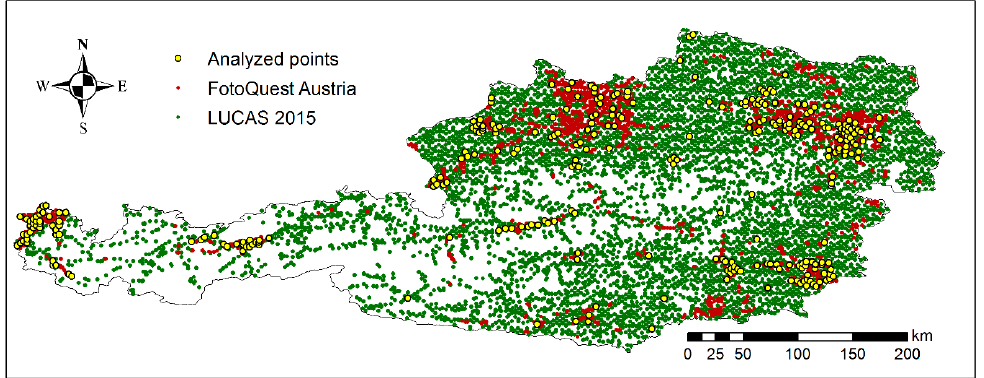
Figure 4. Overlay of FotoQuest Austria and LUCAS 2015 points used in the analysis. Red points are the points visited during the FotoQuest Austria campaign. A large swath of points ( N = 371) was not considered in the analysis due to the reasons listed in Section 3.1.